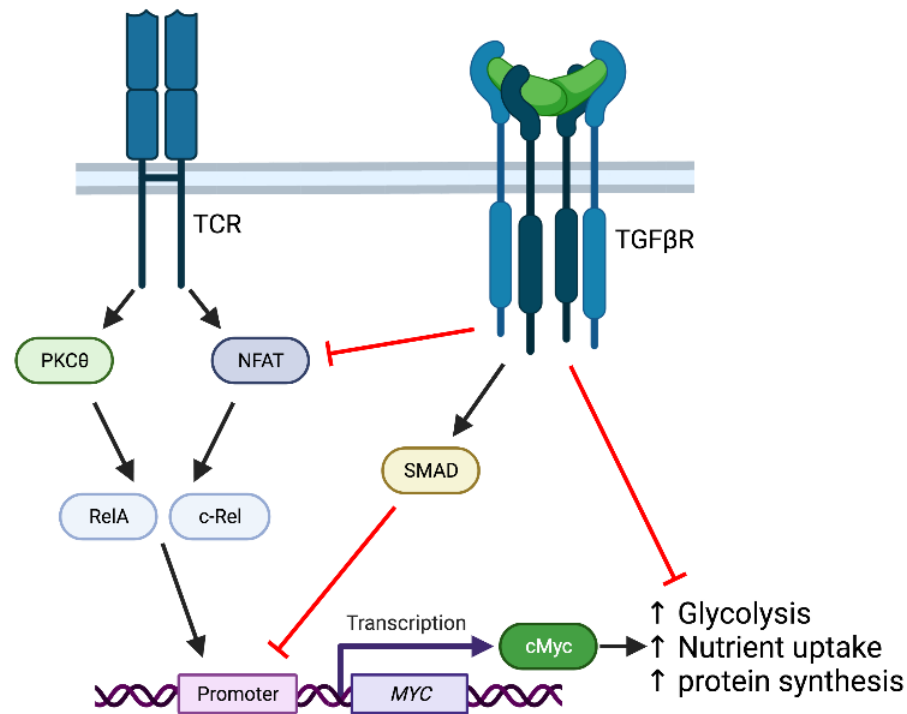
Figure 2. TGF β signalling inhibits TCR-dependent Myc upregulation and metabolic reprogramming in CD8 + T cells. TCR signaling triggers activation of PKCtheta and NFAT that regulate RelA nuclear import and c-Rel gene expression. RelA and c-Rel regulate transcription of Myc that in turn facilitates upregulation of glycolytic metabolism, nutrient uptake and protein synthesis [11,15]. TGF β receptor (TGF β R) signals inhibit NFAT activation [66], whilst SMADs bind directly to the promoter region and suppress transcription of Myc [67,68]. Image created in Biorender.com.